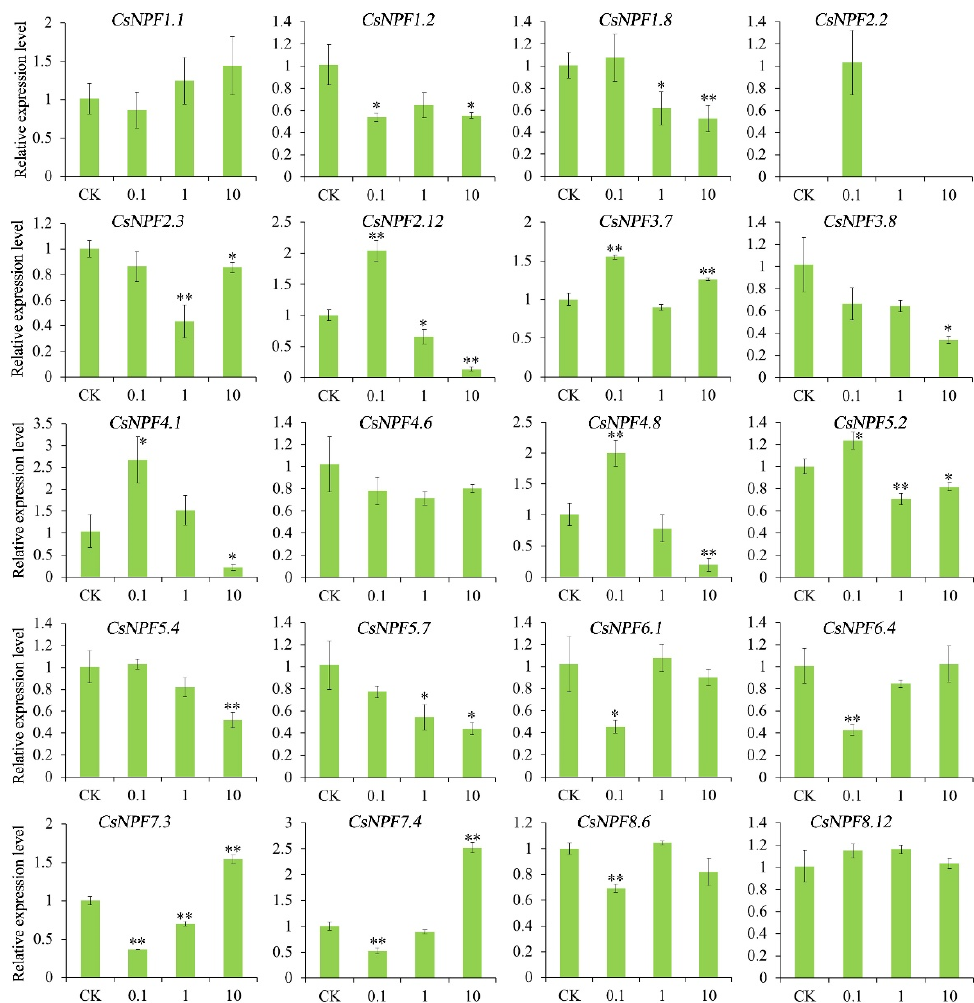
Figure 10. Expression of selected CsNPF genes under different nitrate concentrations. Error bars represent standard deviation (SD). “*” and “**” represent the significance level of 0.05 and 0.01, respectively.